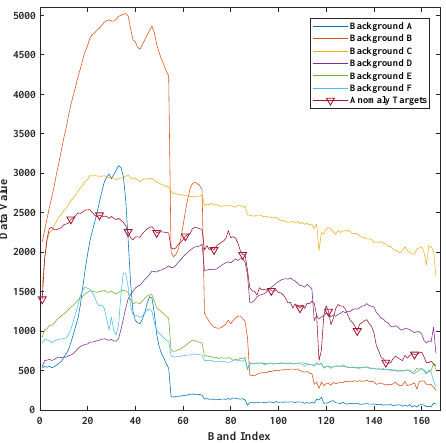
Figure 6. The spectral signature of anomaly targets and background pixels of San Jose.